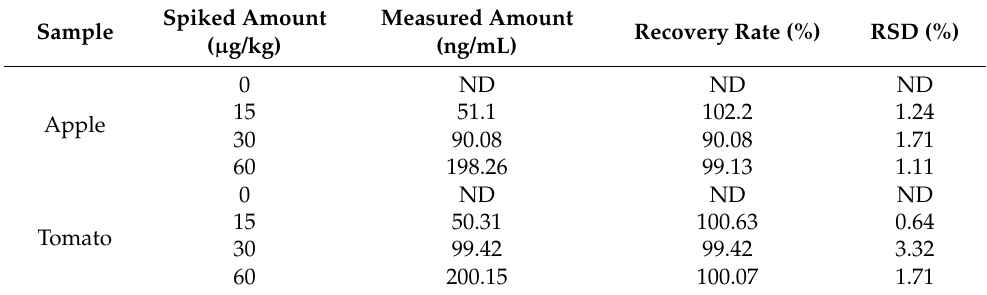
Table 2. Determination of chlorpyrifos in the actual